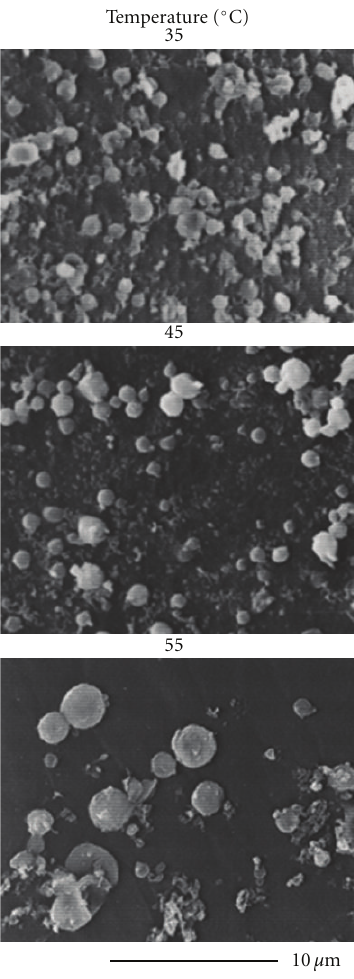
Figure 5: SEM images of the polymer particles obtained at 35, 45, and 55 ◦ C at the cloud point pressure − 300